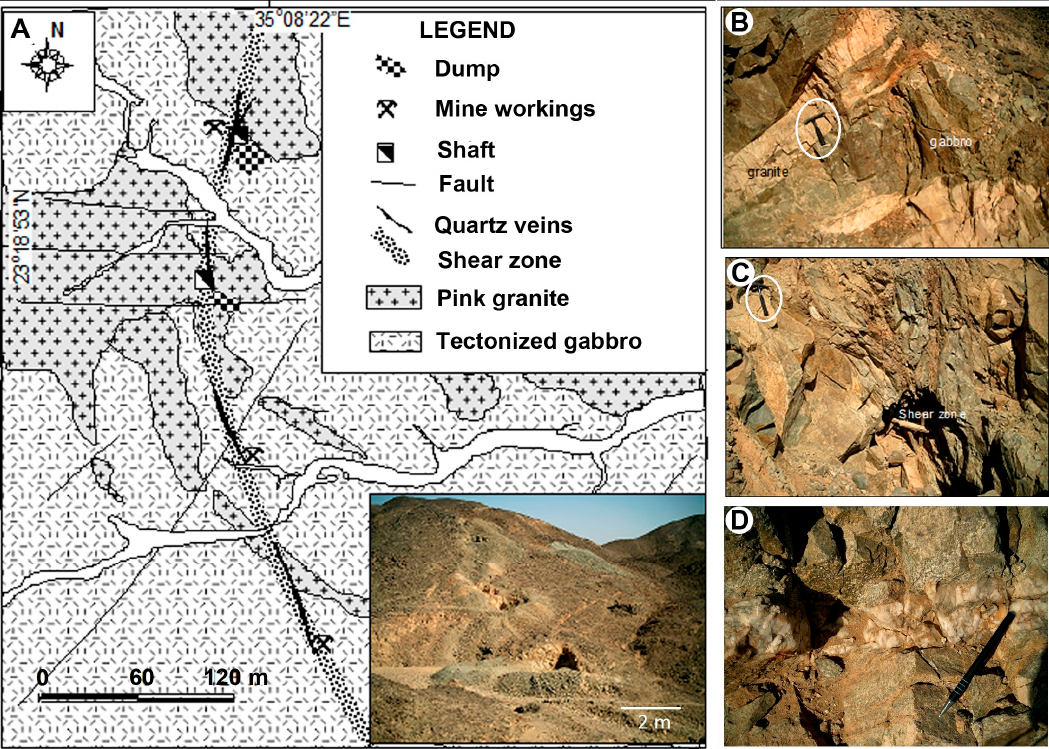
Figure 15. ( A ) Geologic map of the Um Teneidab gold mine, modified from Hassan and El- Figure15. ( A )GeologicmapoftheUmTeneidabgoldmine, modifiedfromHassanandEl-Manakhly[69]. Manakhly [69]. The inset photo shows the mine shafts along the ~N–S line as in the map (photo The inset photo shows the mine shafts along the ~N–S line as in the map (photo looking to N); ( B ) granite looking to N); ( B ) granite offshoots cut the host gabbroic rocks and are associated with zones of o ff shoots cut the host gabbroic rocks and are associated with zones of discoloration in the mine area discoloration in the mine area (photo looking to W); ( C ) shear zone with quartz veins between (photo looking to W); ( C ) shear zone with quartz veins between tectonized gabbro and fine-grained tectonized gabbro and fine-grained granite (photo looking to N); ( D ) milky quartz vein cutting granite (photo looking to N); ( D ) milky quartz vein cutting across granite at the Um Teneidab gold across granite at the Um Teneidab gold mine. Notice the color bleaching of the wallrocks. mine. Notice the color bleaching of the